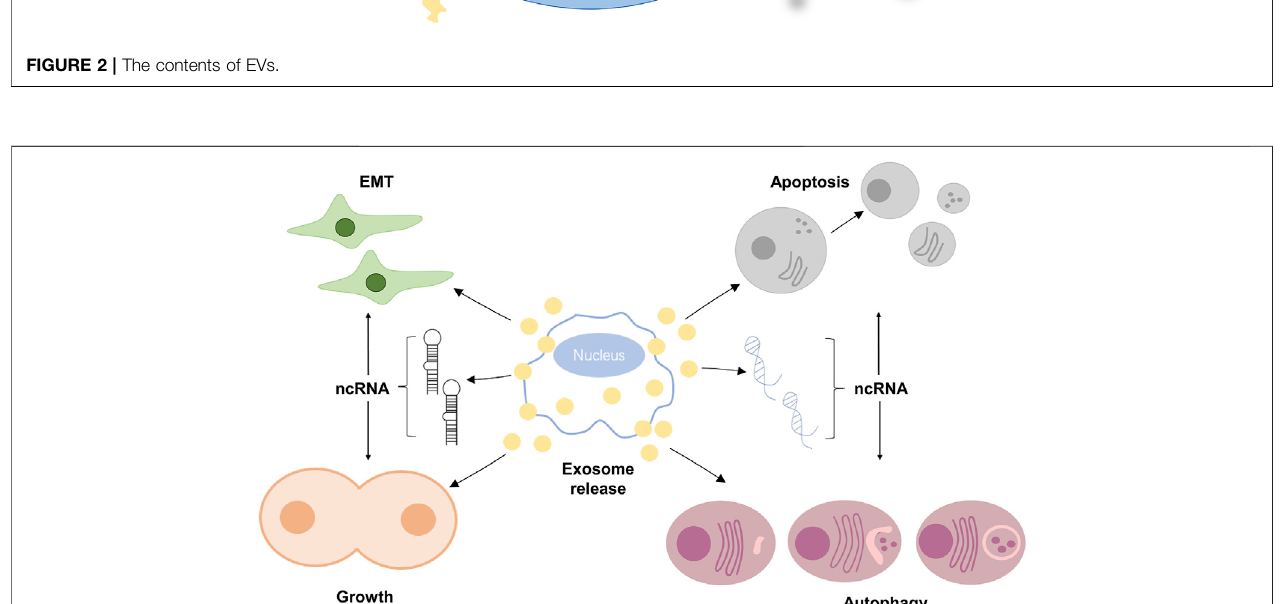
FIGURE 3 | EVs decide cell